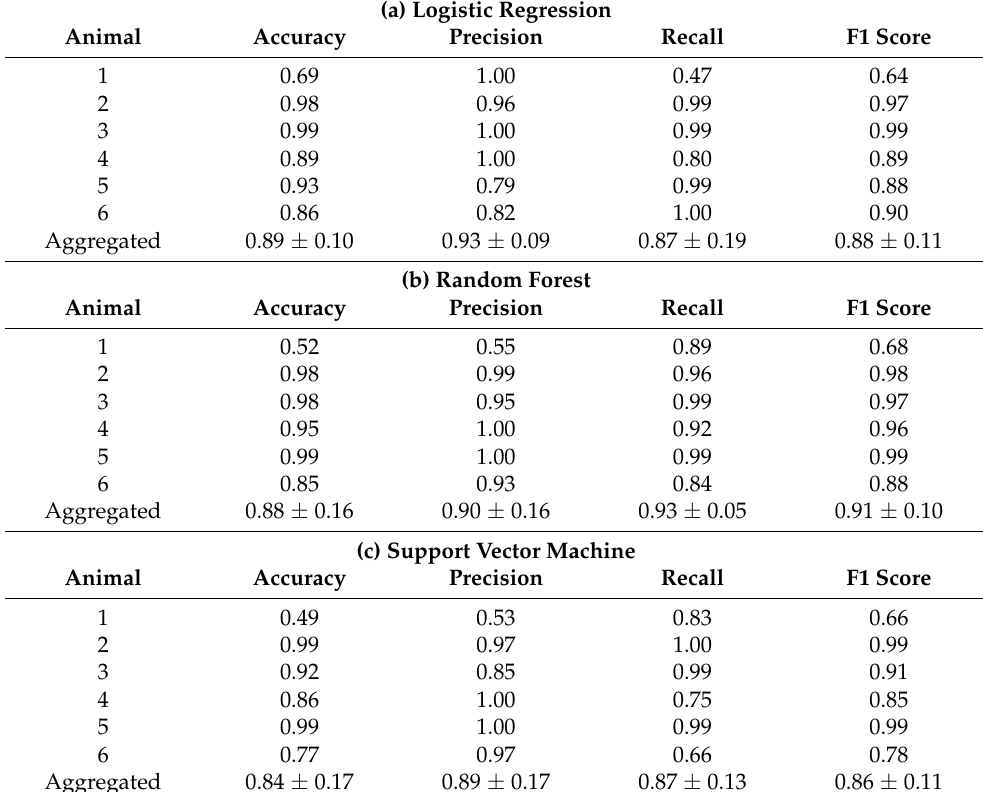
Table 2. Performance of 2nd-stage classifier based on leave-one-subject-out analysis. Aggregated performance is shown in terms of mean and standard